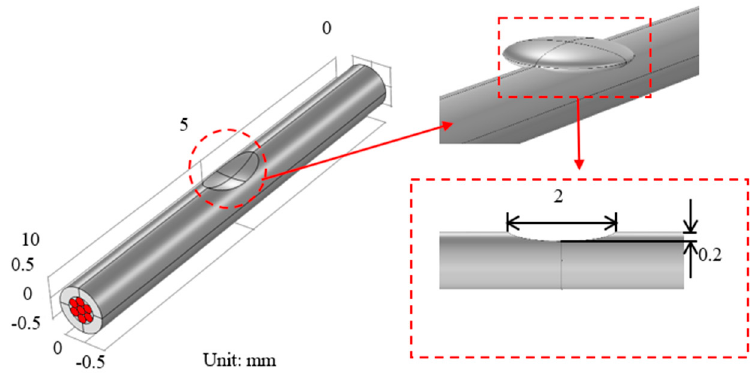
Table 1. Cable model material parameters.